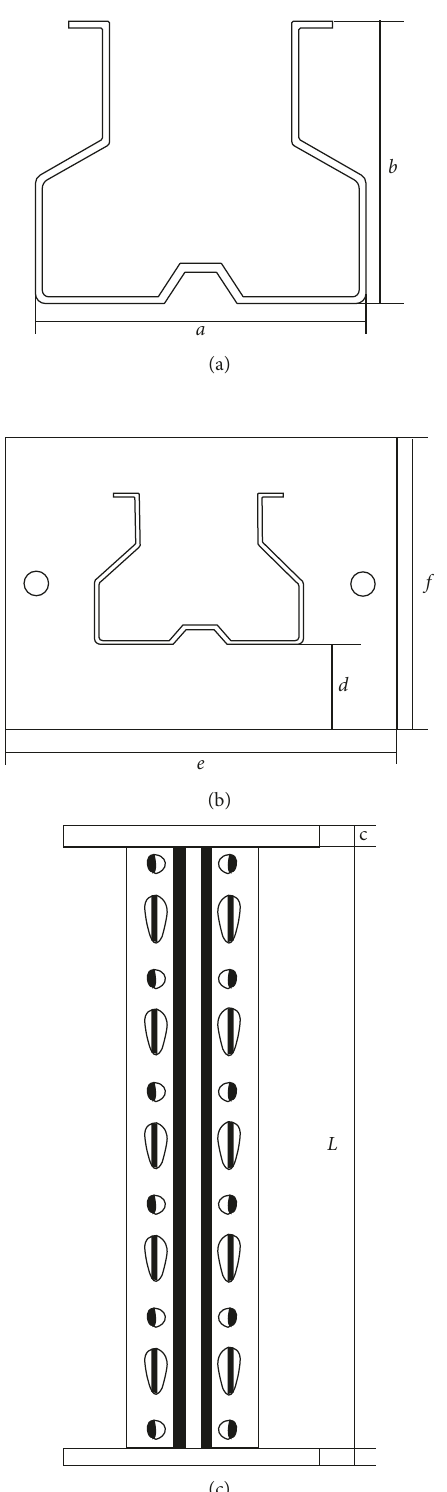
Figure 5: Parameters of column test.